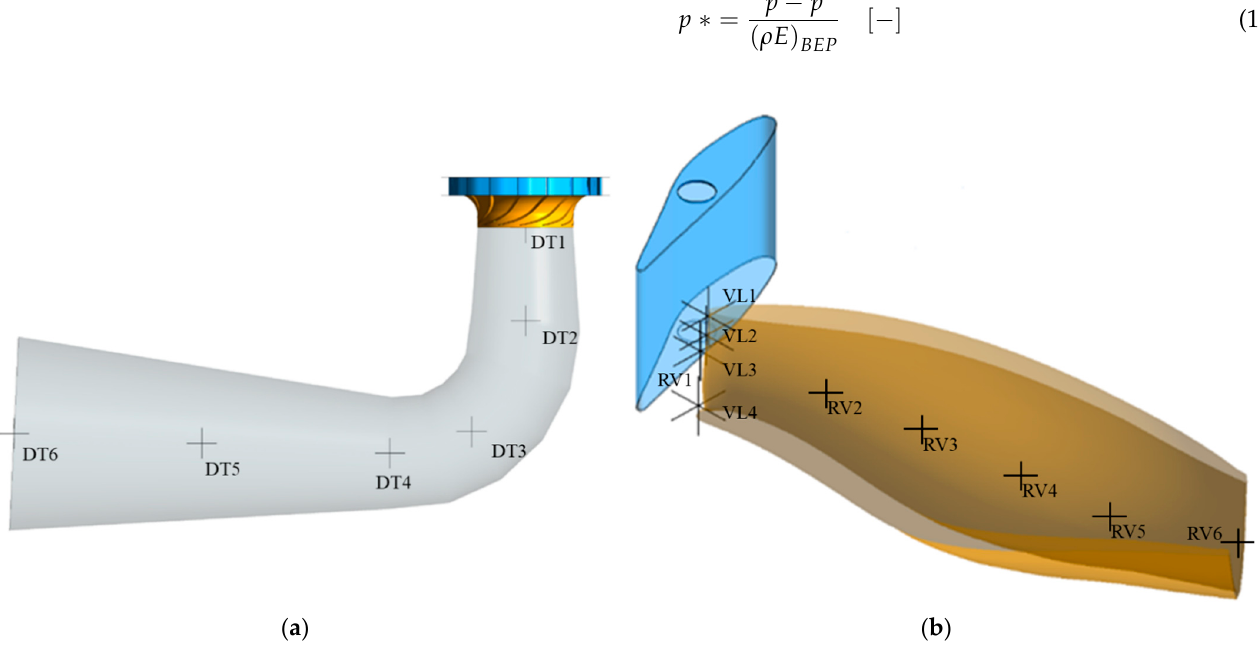
Figure 14. Points for measurement of pressure pulsations at: ( a ) Six points from DT1 to DT6 inside the draft tube domain; ( b ) Four points from VL1 to VL4 inside the vaneless space and six points from RV1 to RV6 in the runner blade surface for pressure monitoring.